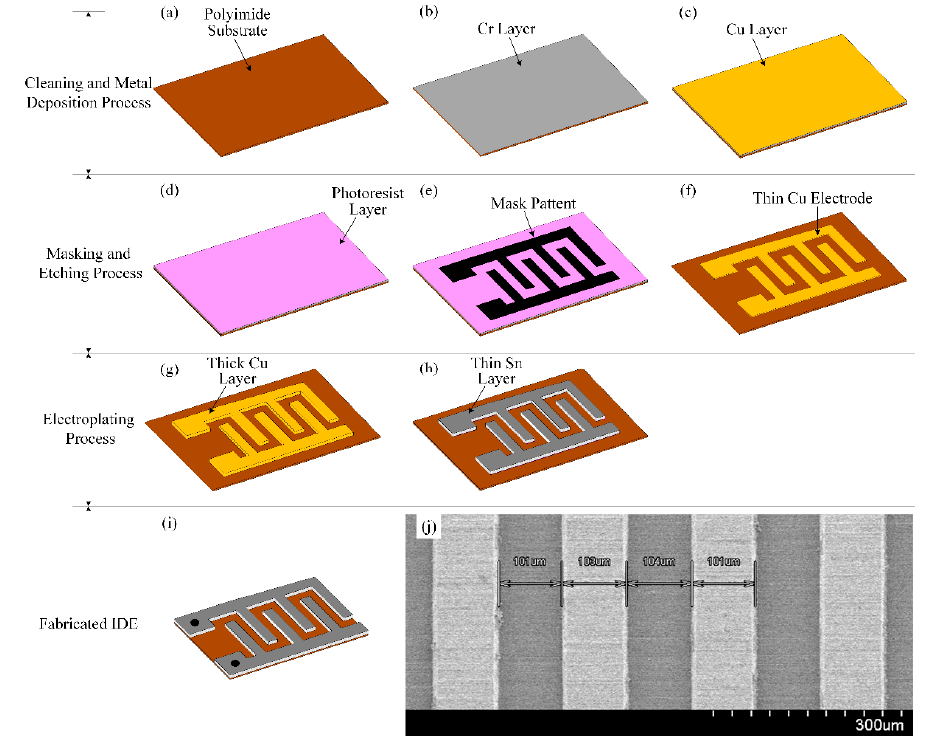
Figure 4. Preparation procedure of the IDE: ( a ) polyimide substrate; ( b ) thin Cr layer on the polyimide substrate; ( c ) depositing a thin Cu layer on the Cr layer; ( d ) photoresist layer, ( e ) transferring the mask pattern onto the photoresist layer; ( f ) etching the unmasked metal layers; ( g ) depositing the thick Cu layer onto the thin patterned Cu layer via electroplating; ( h ) depositing the thin Sn layer onto the thick patterned Cu layer; ( i ) cutting the residual polyimide substrate; and ( j ) SEM image of the surface of the interdigitated electrode (IDE).